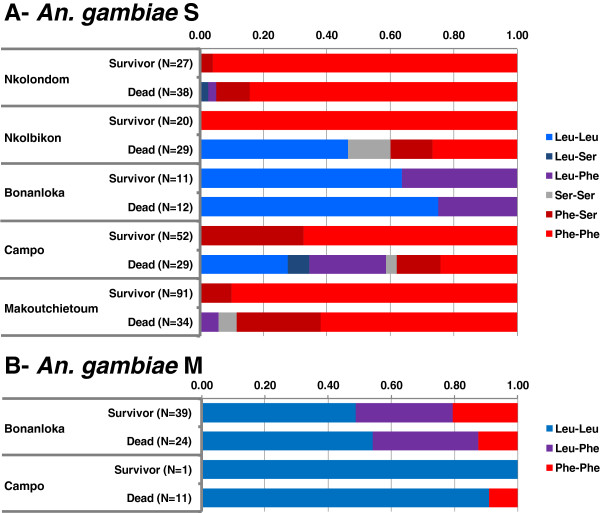
Frequency distribution of the different genotypes at position 1014 of the kdr locus in samples of dead and survivor mosquitoes after exposure to 0.75% permethrin.A) An. gambiae S form; B) An. gambiae M form. Colour key to the different genotypes is given in the insert on the right. Leu: Leucine at position 1014 (encoded by allele 1014L); Phe: Phenylalanine at position 1014 (encoded by allele 1014F); Ser: Serine at position 1014 (encoded by allele 1014S).